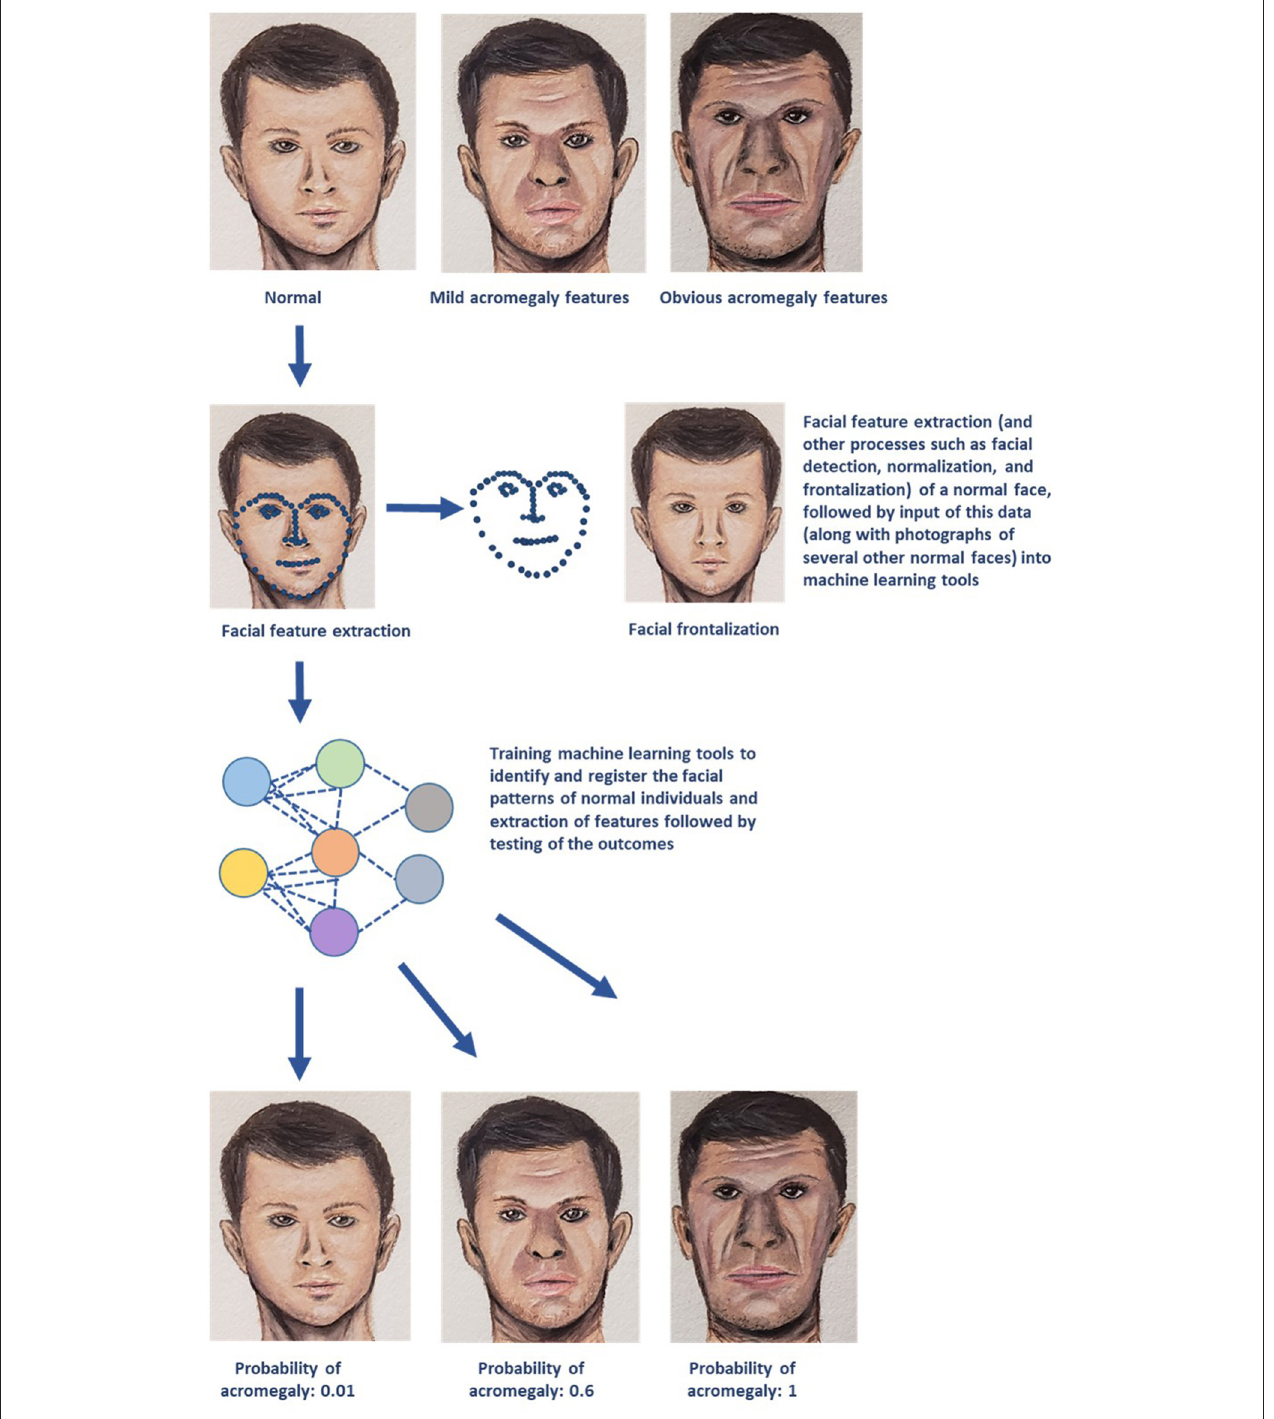
FIGURE 1 | A simplified schematic representation of one of the several machine learning (ML) technologies that can be utilized for diagnosis and management of endocrine disorders. The example demonstrated in the above diagram deals with early recognition of acromegaly based on facial features. Photographs of several individuals with normal facial features are utilized to obtain data on facial patterns through processes such as facial feature extraction (represented by blue dotted lines), facial detection, normalization, and frontalization (also displayed in the figure). This data is then fed into ML algorithms for recognizing normal facial features. These ML tools then perform complex analyses and generate output data that is used to determine whether the face presented in the test photograph is consistent with features of acromegaly (Image courtesy: Sriram Gubbi, NIDDK, NIH).